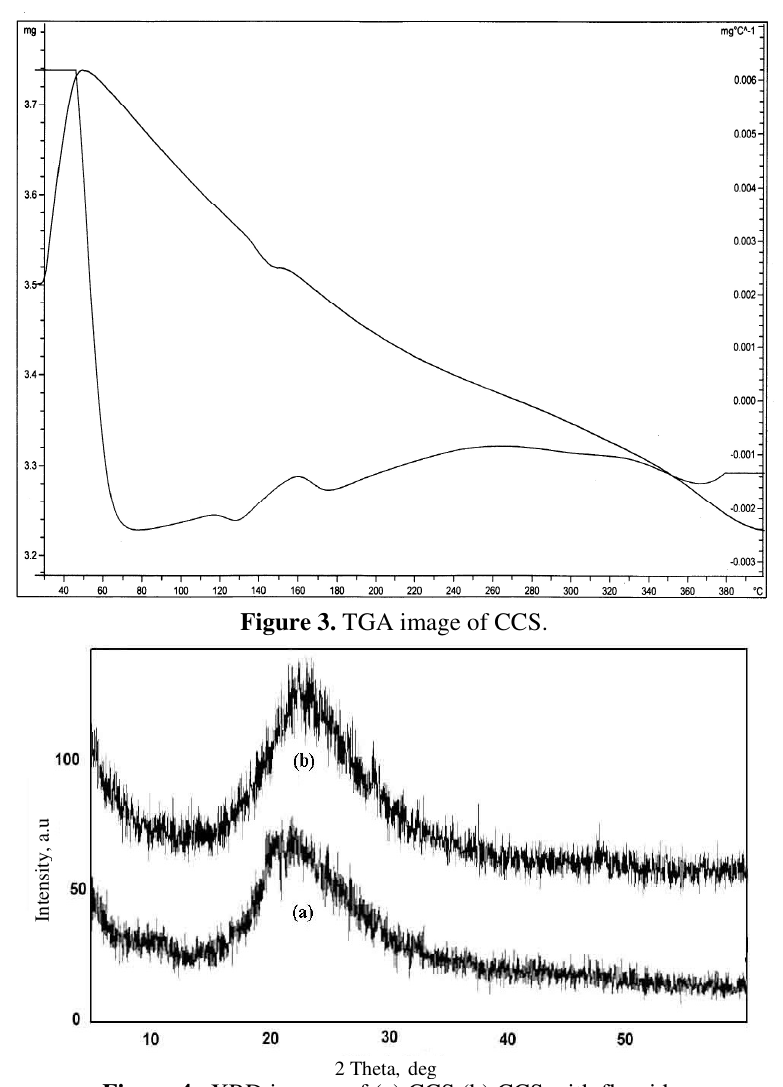
Figure 4. XRD images of (a) CCS (b) CCS with